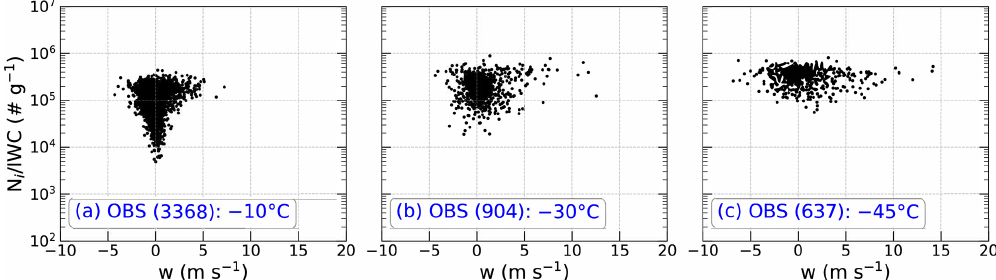
Figure 3. Scatter plots of observed ice number concentration ( N i , no.m − 3 ) divided by ice water content (IWC, gm − 3 ) (denoted as N i / IWC) as a function of vertical velocity ( w , ms − 1 ) in regions with IWC > 1gm − 3 from all flights during the Cayenne field campaign at tempera- tures of (a) − 10 ◦ C, (b) − 30 ◦ C, and (c) − 45 ◦ C, and the observed temperature ranges of samples at the three levels are − 12 . 9 to − 7 . 3 ◦ C, − 33 . 0 to − 27 . 3 ◦ C, and − 45 . 4 to − 42 . 4 ◦ C, respectively. The numbers in parentheses represent the total number of samples.